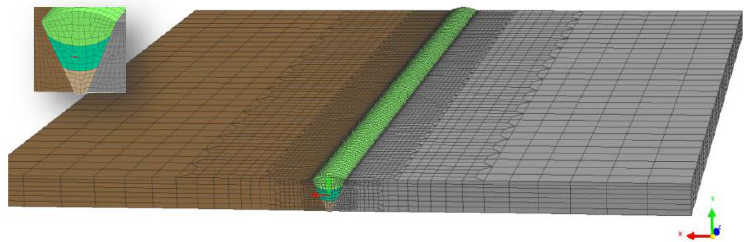
Figure 3. Numerical model for structural weld simulation in case of test series √area > 1000 µm [30].